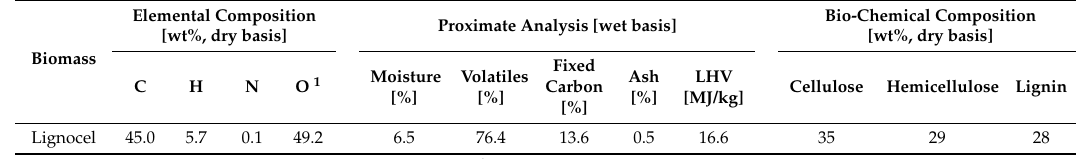
Table 2. Ultimate and proximate analysis, and bio-chemical composition of biomass.